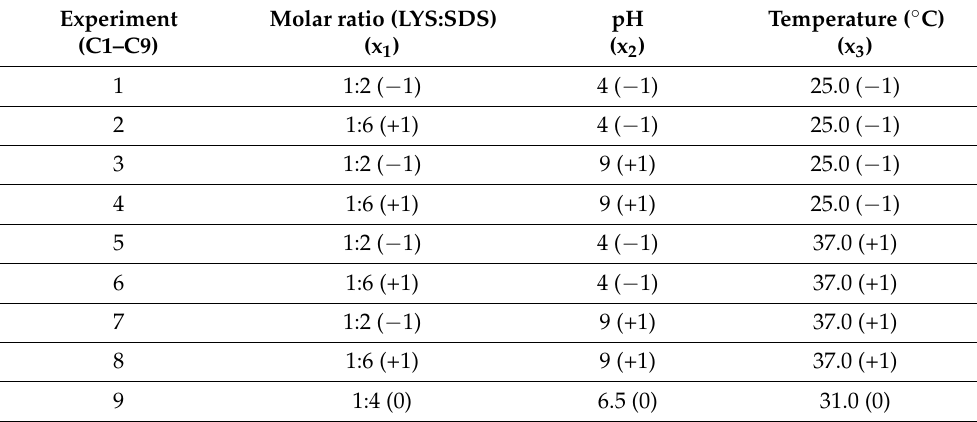
Table 1. Design matrix for full factorial design with three factors, at two levels with one central point.